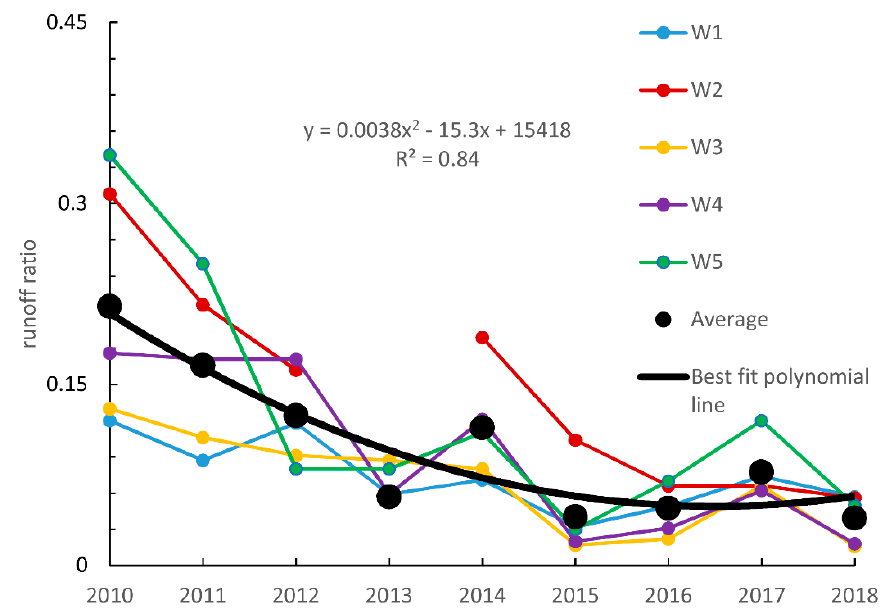
Figure 6. Runoff coefficients during the rain phase from 2010 to 2018 for the Debre Mawi watershed. Note watershed W2 was not monitored in 2013. The black line is the best polynomial fit line of the average runoff ratio of the five watersheds.